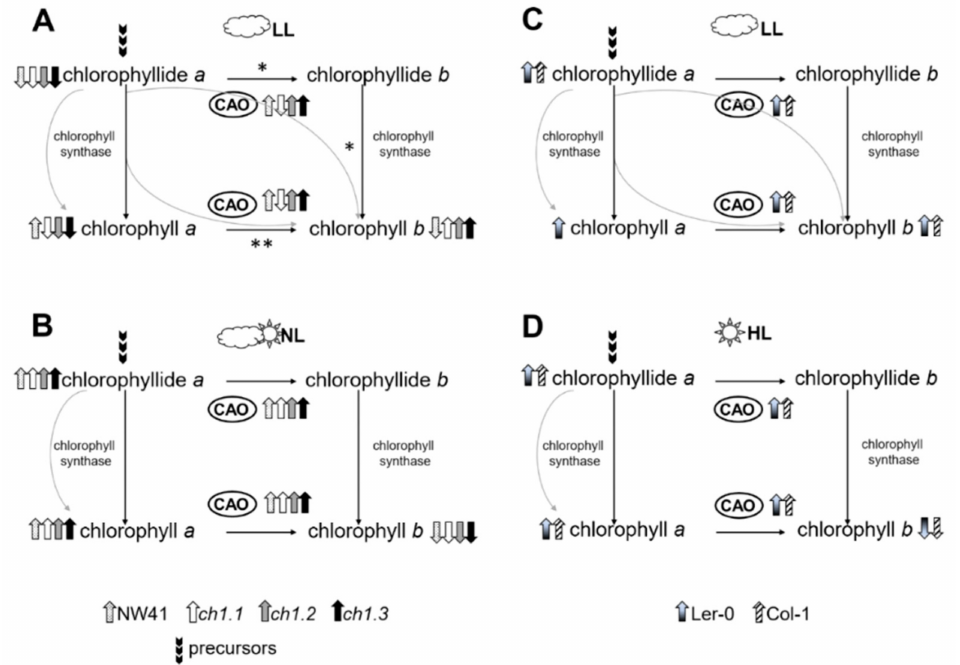
Figure 8. Routes of chlorophyll a to b conversion. Two possible routes of chlorophyll a to b conversion were previously described (Tanaka and Tanaka, 2019). In the first route (*), chlorophyll a is dephytilated by chlorophyllase and then converted to chlorophyll b by chlorophyllide a oxygenase (CAO) and chlorophyll synthase. In the second route (**), chlorophyll a is directly converted to chlorophyll b by CAO activity. Both of the routes were presented separately for all investigated plants in the applied light conditions: normal light (NL), low-light (LL), high-light (HL). ( A )—for ch1 mutants: NW41, ch1.1 , ch1.2 , ch1.3 , in LL; ( B )—for ch1 mutants: NW41, ch1.1 , ch1.2 , ch1.3 , in NL; ( C )—control plants: Ler-0 and Col-1, in LL; ( D )—control plants: Ler-0 and Col-1, in HL. Arrows correspond to the increase/decrease in a specified chlorophyllide/chlorophyll amount and level of CAO mRNA in response to the applied light